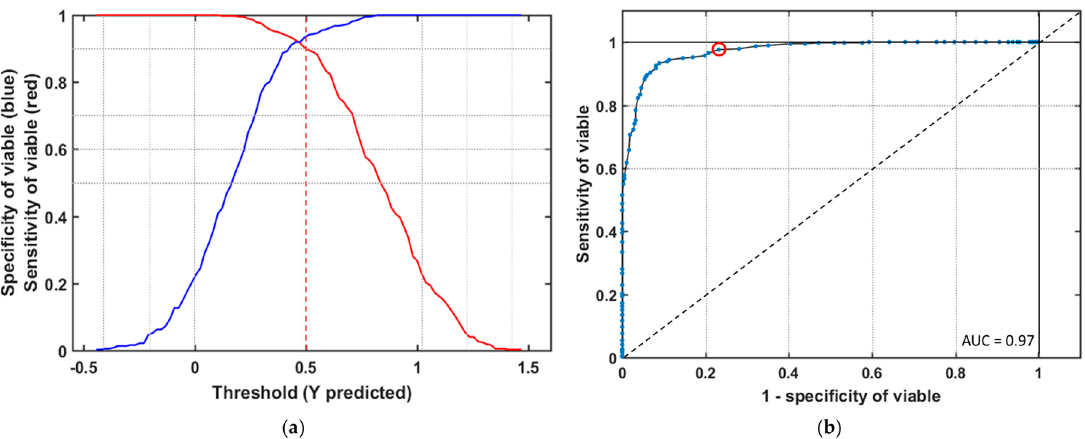
Figure 5. ( a ) Effective threshold selection for partial least discriminant analysis (PLS-DA) based seed viability classification (the line in red color is the sensitivity and blue color is the specificity of viable seed); ( b ) Receiver operating characteristics curve for viable seed detection from the general model.